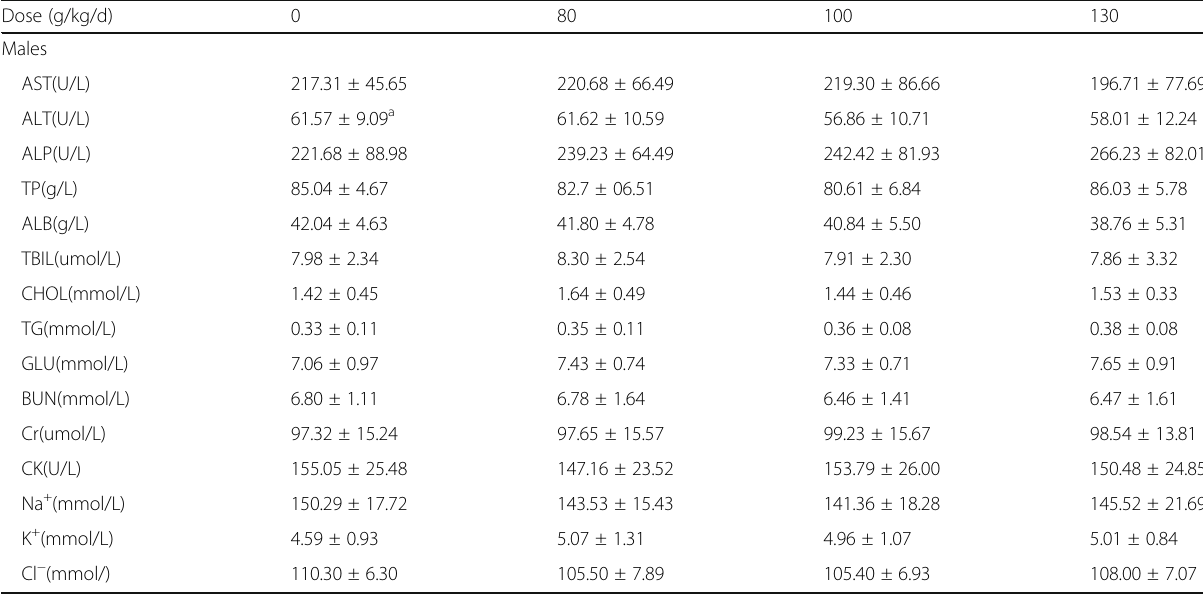
Table 8 Clinical chemistry data for male rats treated with JDHY granules for 13 weeks